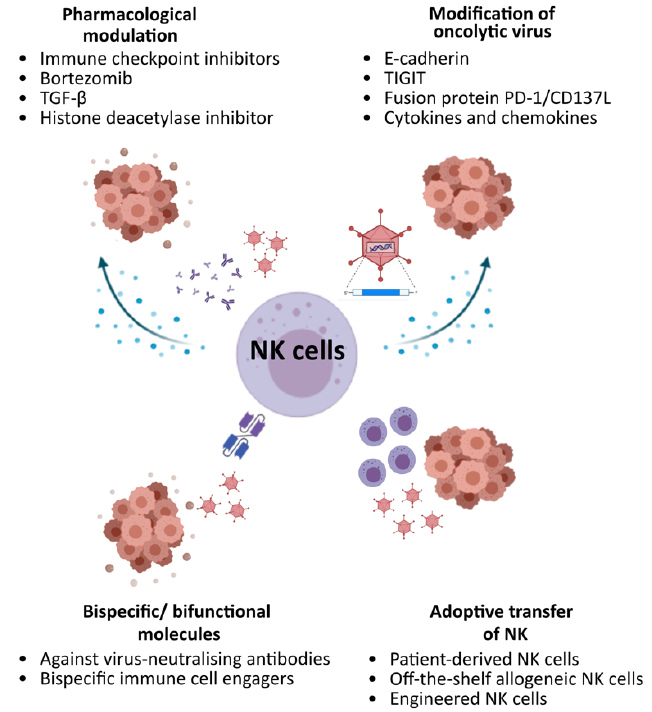
Figure 2. Potential strategies to augment OV activities via NK cells.